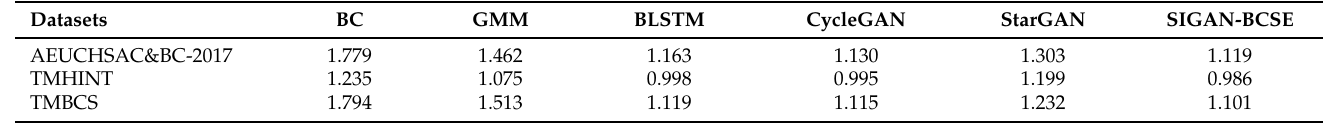
Table 5. LSD evaluation of the enhanced BC speech obtained by different methods (double-ended